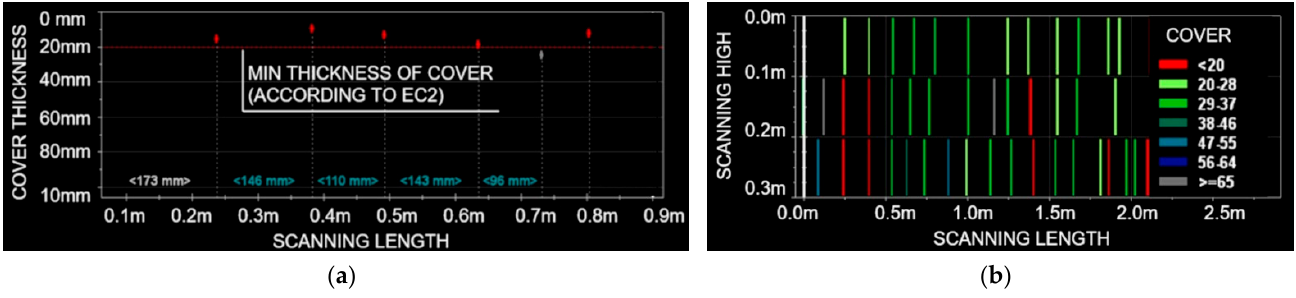
Figure 7. Results of electromagnetic scans: ( a ) linear scan; ( b ) multilinear scan.